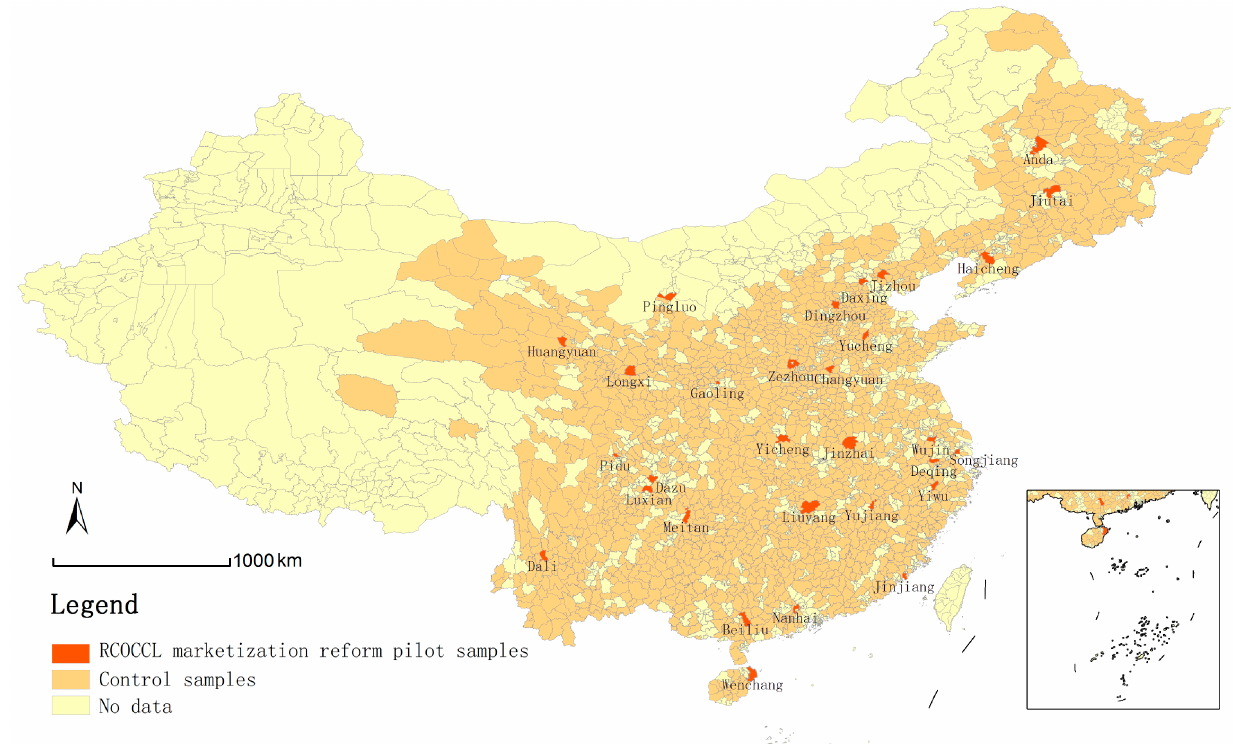
Figure 2. Spatial distribution of the RCOCCL marketization reform pilot areas.